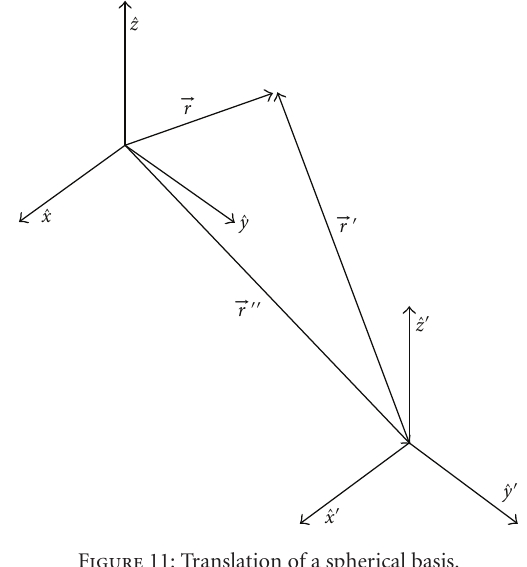
Figure 11: Translation of a spherical basis. Table 2: Comparison between mutual